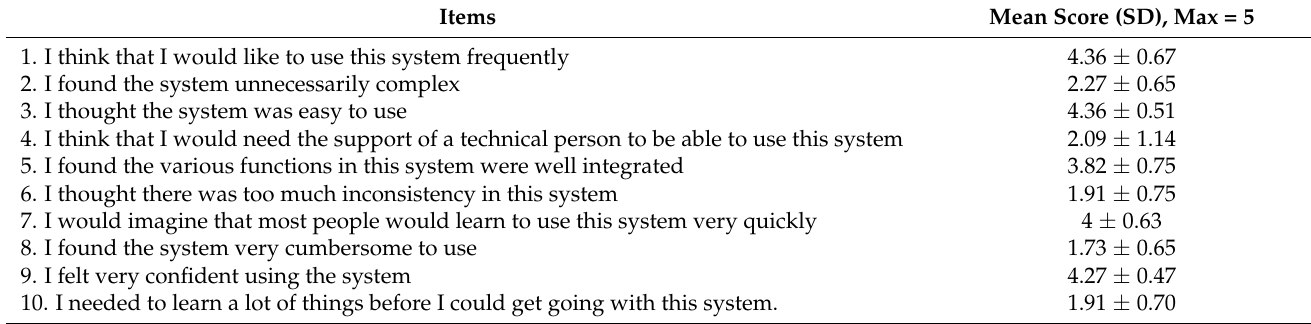
Table 3. System Usability Scale ( n =